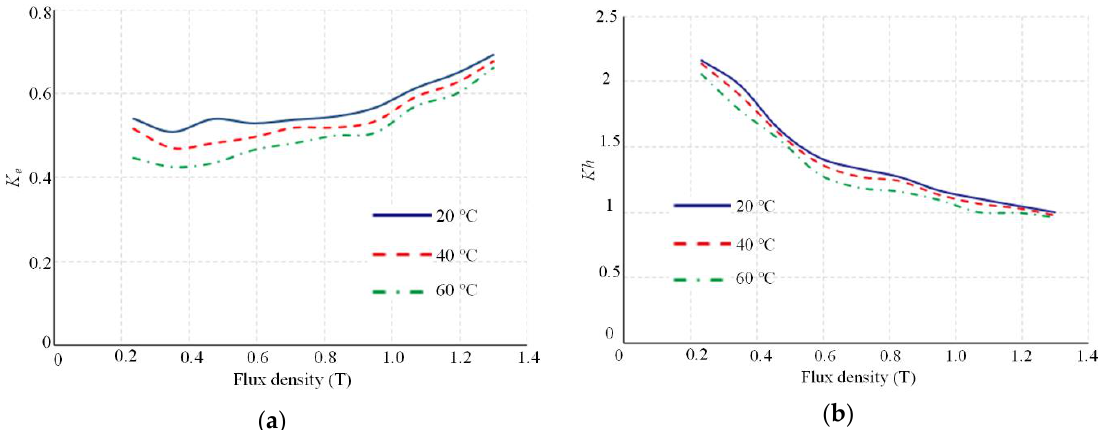
Figure 3. Loss coefficients K e and K h obtained by the experiments. ( a ) Eddy current loss coefficient Ke . ( b ) Hysteresis loss coefficient K h .